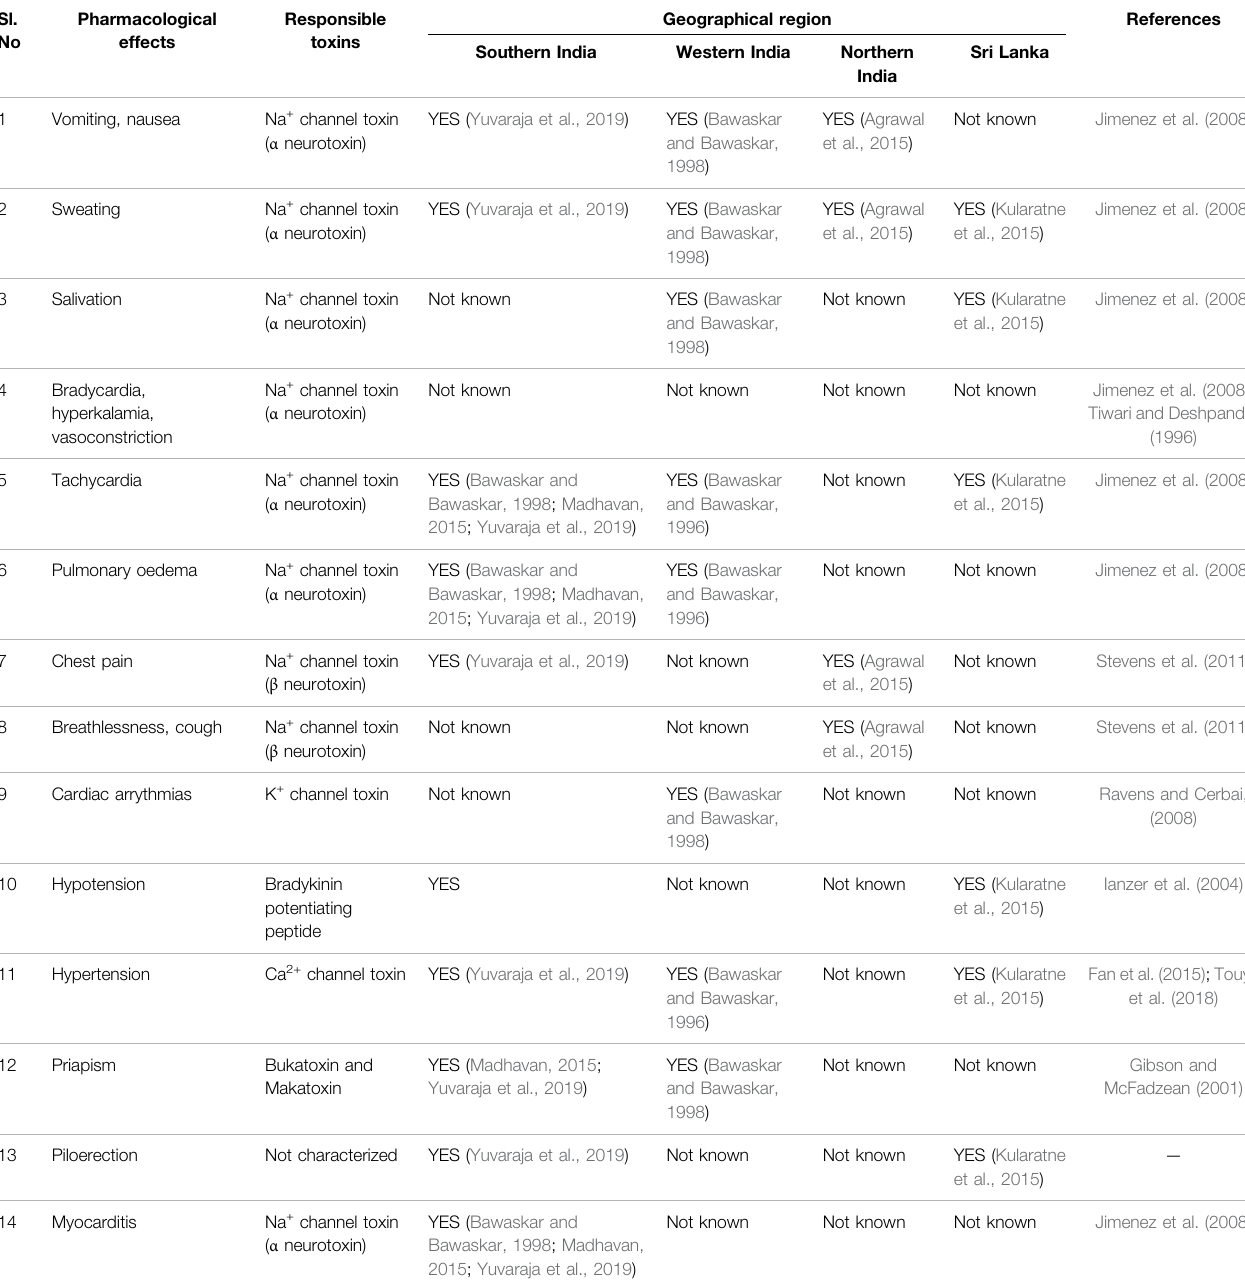
TABLE 2 | Comparative list of the pharmacological effects induced by toxins from Indian red scorpion venoms of different geographical regions. Sl.